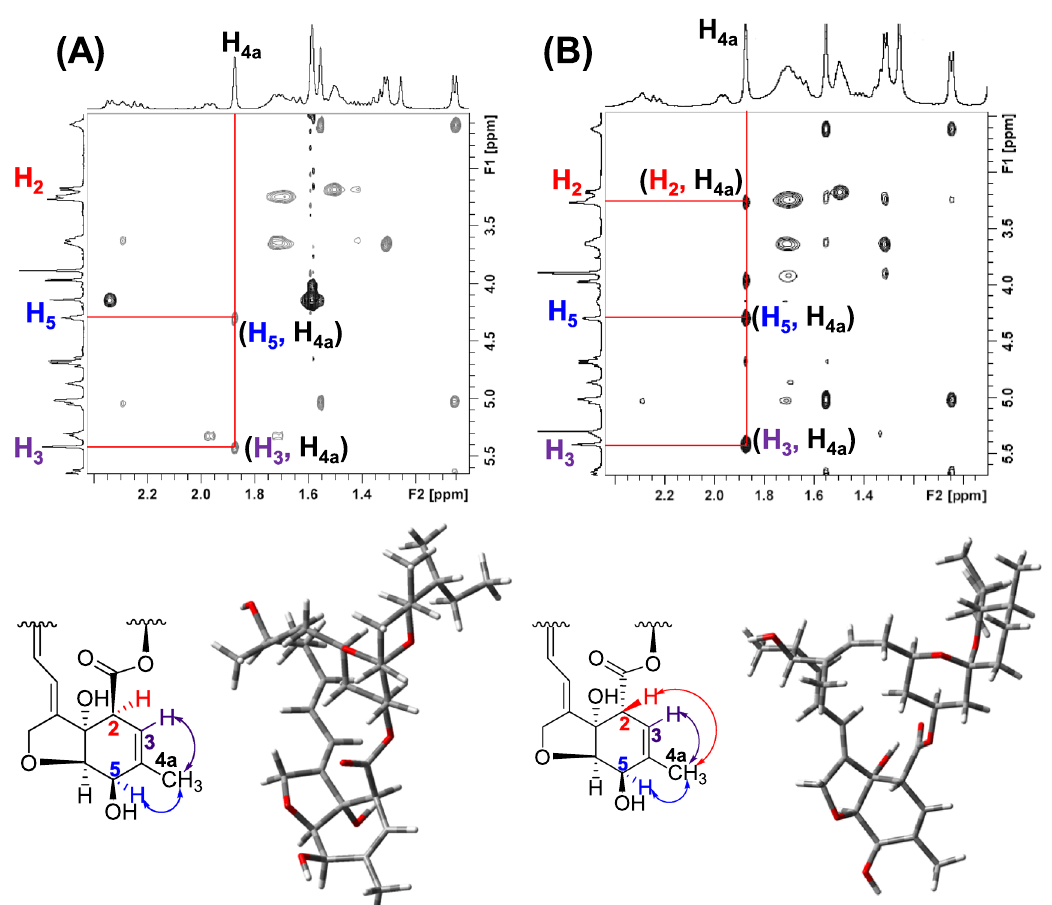
Figure 8. NOESY spectra (in part) of ( A ): 15a ; ( B ): 15b showing oxahydrindene unit and the corresponding DFT optimized structures depicting aglycon